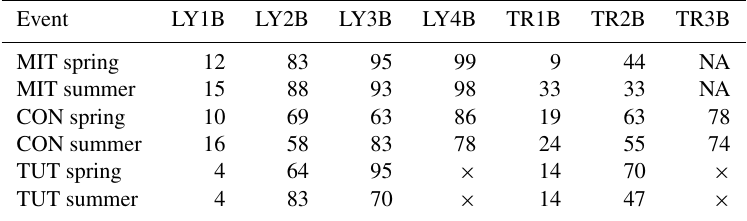
Table 3. Mean pre-event water fraction (%) of the different flow components (trench: TR1B, TR2B, TR3B and lysimeter: LY1B, LY2B, LY3B, LY4B) and the six sprinkling experiments in Mitterfels (MIT), Conventwald (CON) and Tuttlingen (TUT) in spring and summer. The × indicates that this lysimeter or trench does not exist (TUT), and NA indicates that a lysimeter or trench did not yield any flow (MIT). Event LY1B LY2B LY3B